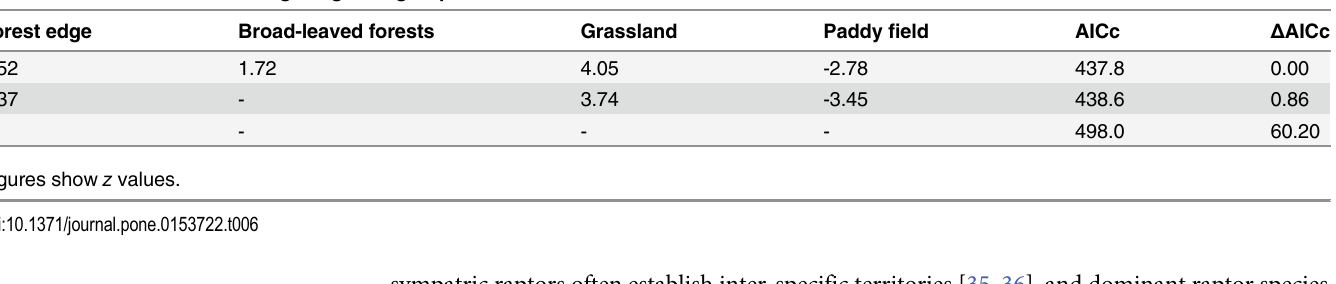
Table 6. Selected models for single regional-group.